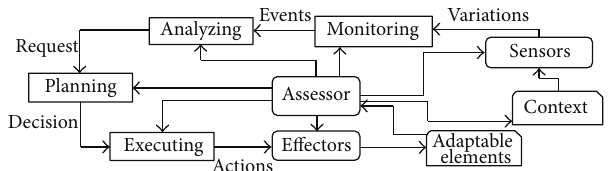
Figure 2: Global architectural view of the adaptive